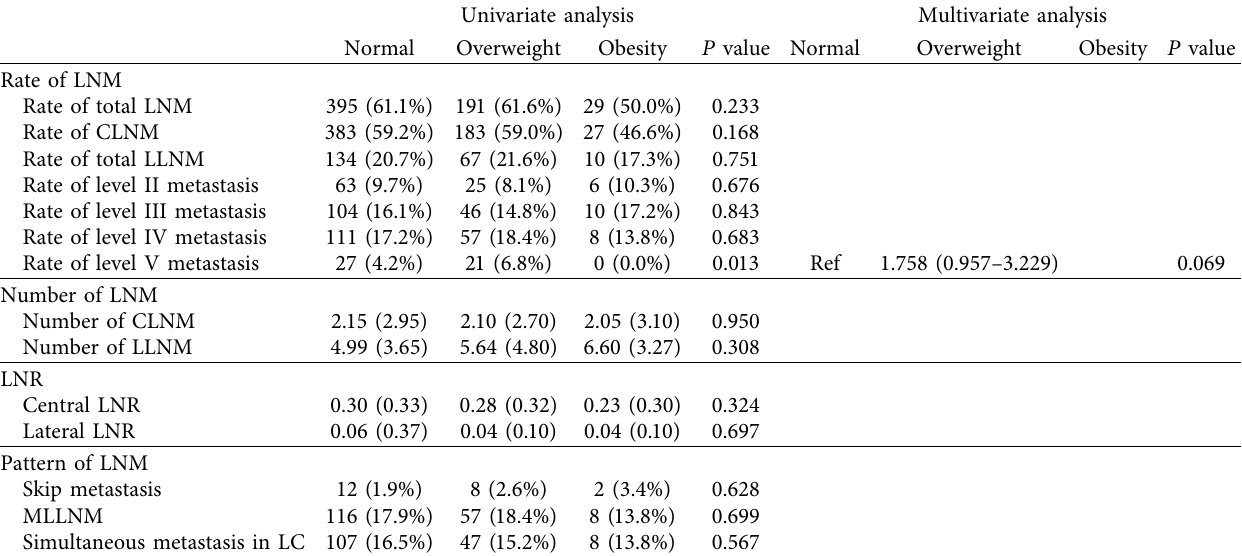
Table 2: Relationship between BMI and diferent regional lymph node